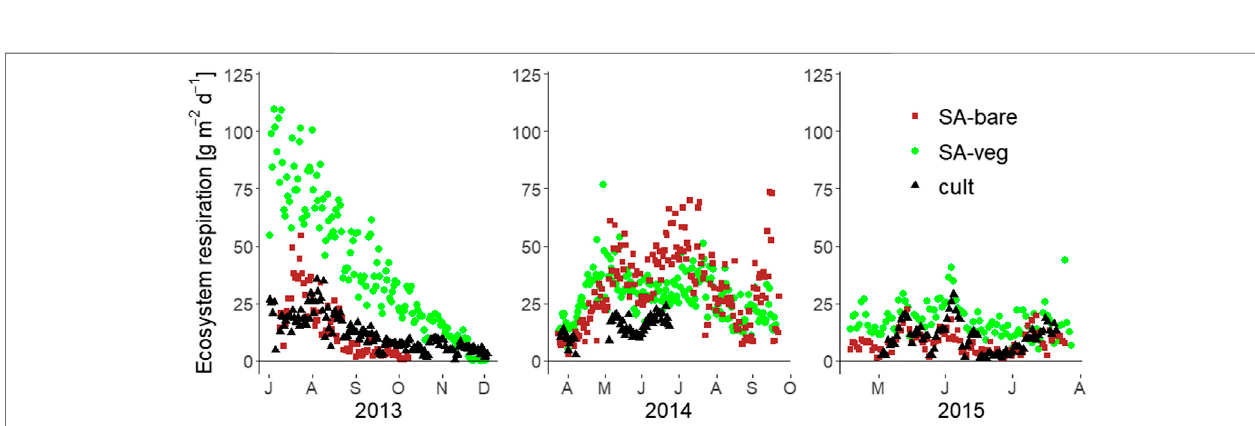
FIGURE 5 | Daily global radiation (top) , air temperature (middle) , and precipitation (bottom) in 2013, 2014, and 2015, measured at the nearest of fi cial meteorological station (Kerstinbo) to the study site.